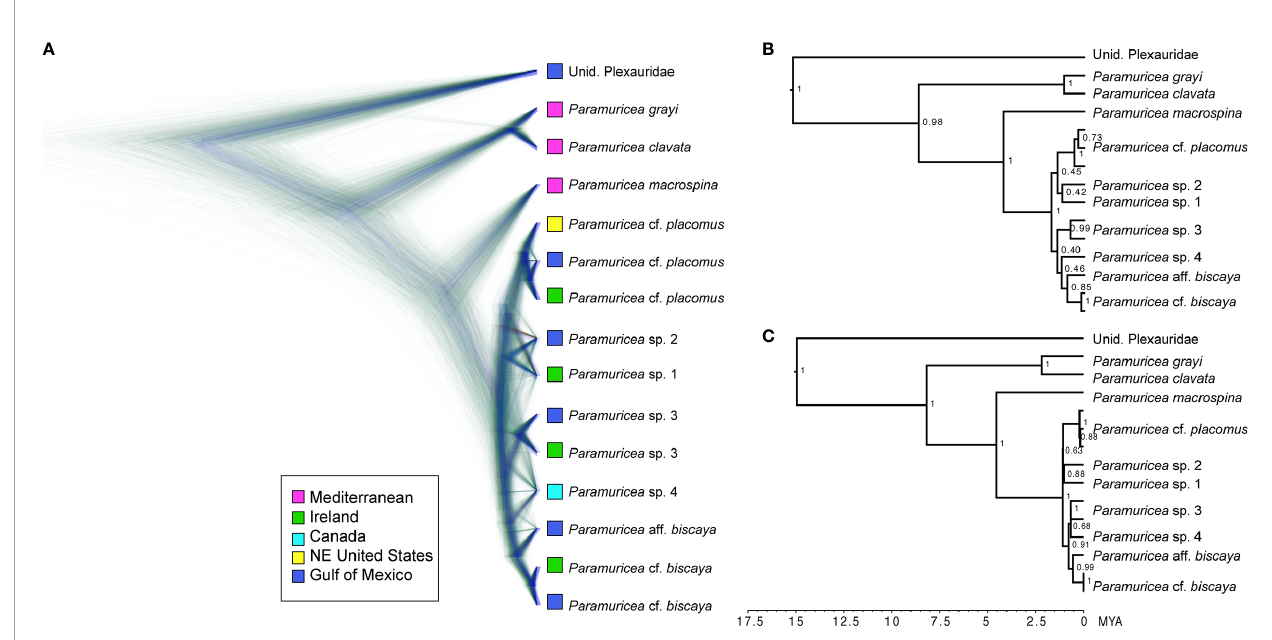
FIGURE 3 | Species tree of Paramuricea using SNAPP_subset1 (958 unlinked, bi-allelic SNPs). (A) Cloudogram includes the undated maximum clade credibility (MCC) tree and congruent trees in blue and trees with different topologies in red and green. Tips are color-coded to sampling location. (B) Undated MCC tree with posterior probabilities at internal nodes. (C) Dated MCC Tree with posterior probabilities at internal